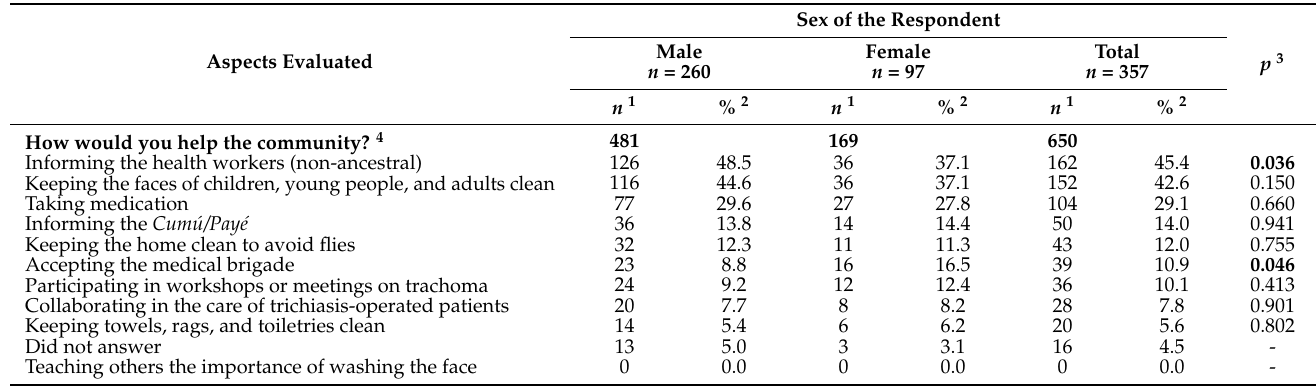
Table 3. Participant responses (by sex) to their contribution to prevent trachoma in the community in the knowledge, attitudes, and practice